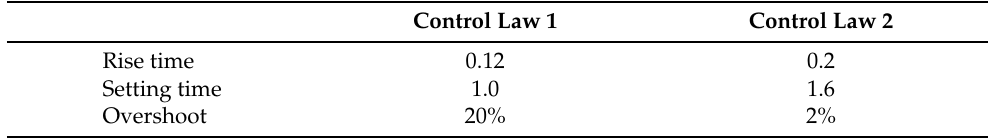
Table 2. Performance of altitude